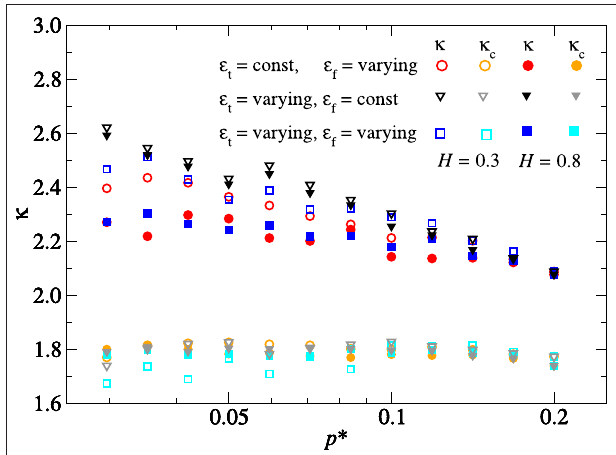
FIGURE 7 | Same as Figure 4 , however, this time for stochastically 0.3 and anisotropic surfaces with γ P = for κ c rather than for κ 1 / 4, = ε f 1 / 1,000. The dashed ≤ ≤ 0.5 ≈